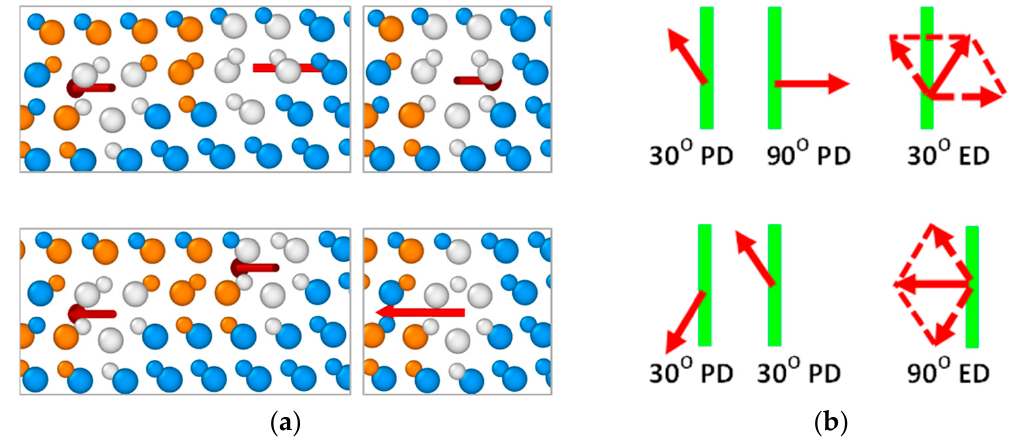
Figure 4. ( a ) MD simulation snapshots and ( b ) schematic top views of the formation of stable 30° (top images) and 90° (bottom images) extrinsic partial dislocations in 3C-SiC. Arrows indicate the directions of the dislocation and dislocation complexes Burgers vectors. Vertical lines in part ( b ) correspond to the dislocation lines.